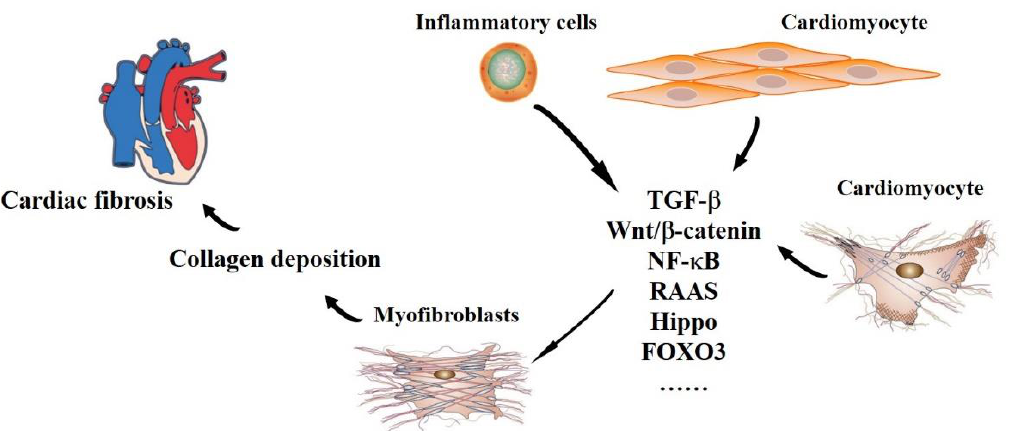
Figure 1. The pathophysiology of cardiac fibrosis. Cardiomyocytes, cardiomyocytes, and inflam- matory cells participate in the process of cardiac fibrosis during related pathways.